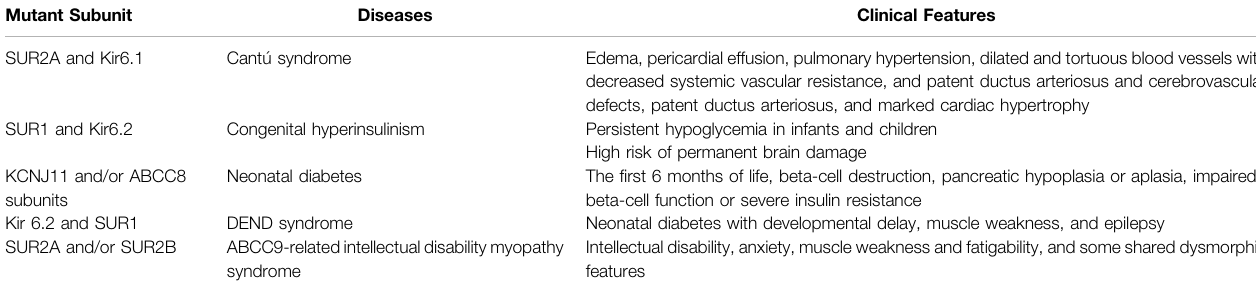
TABLE 3 | Multiple subunit mutation-related disease and clinical manifestations. Mutant Subunit Diseases SUR2A and